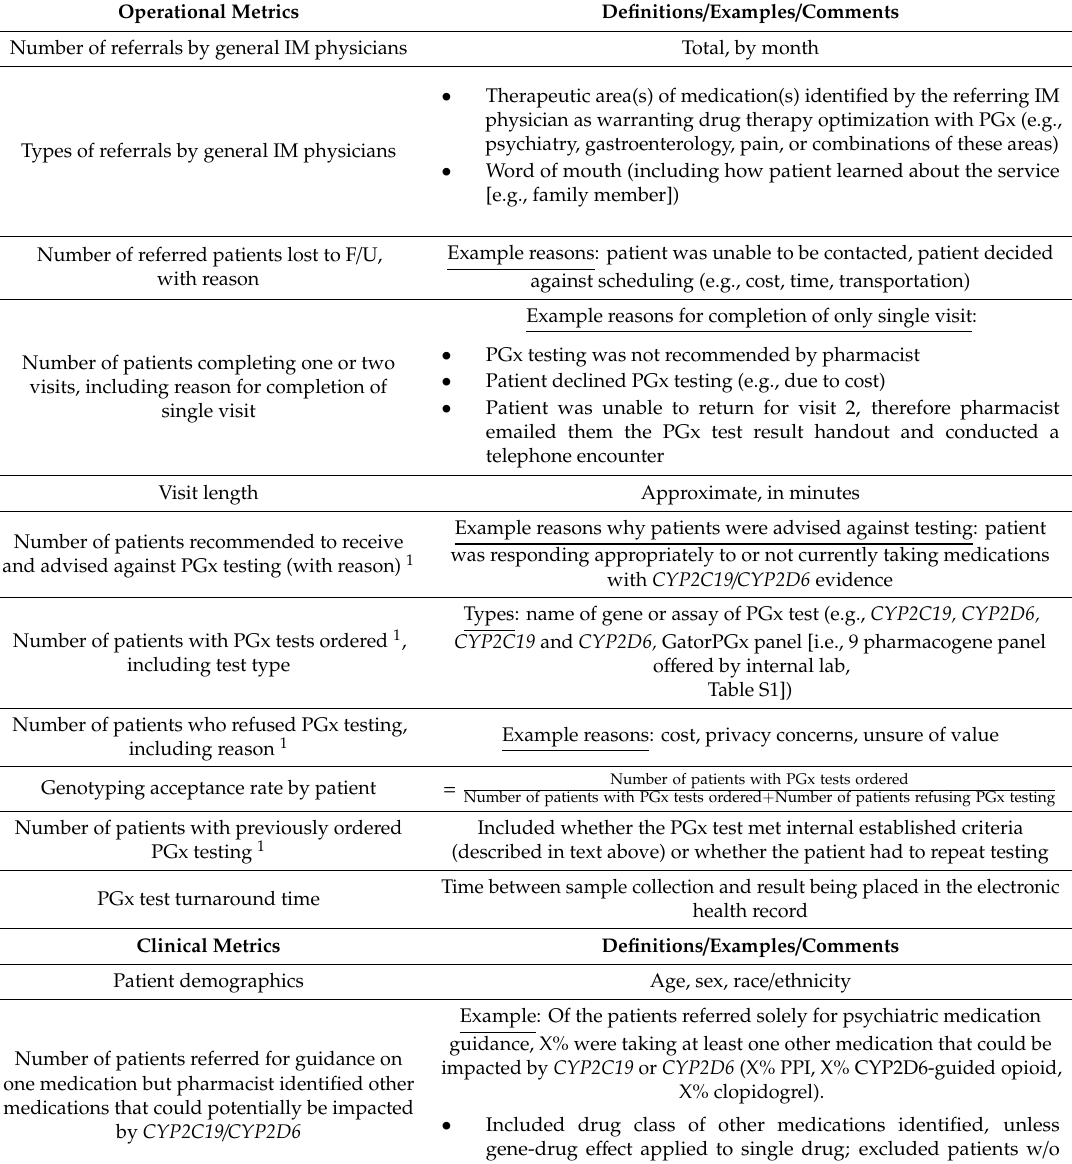
Table 1. Operational and clinical metrics collected by the pharmacist on the pharmacogenetics consult